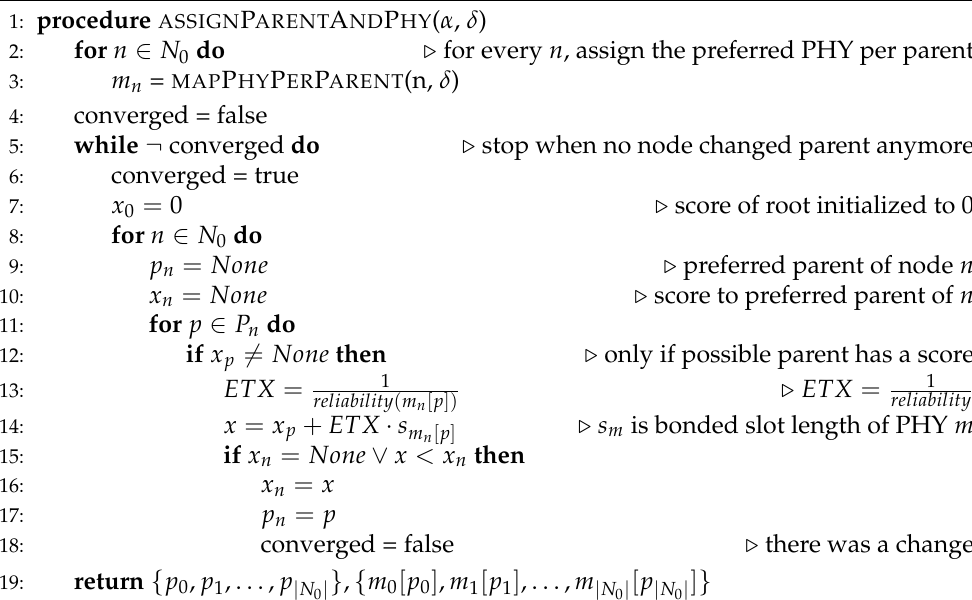
Algorithm 2 Heuristic to find preferred parents and